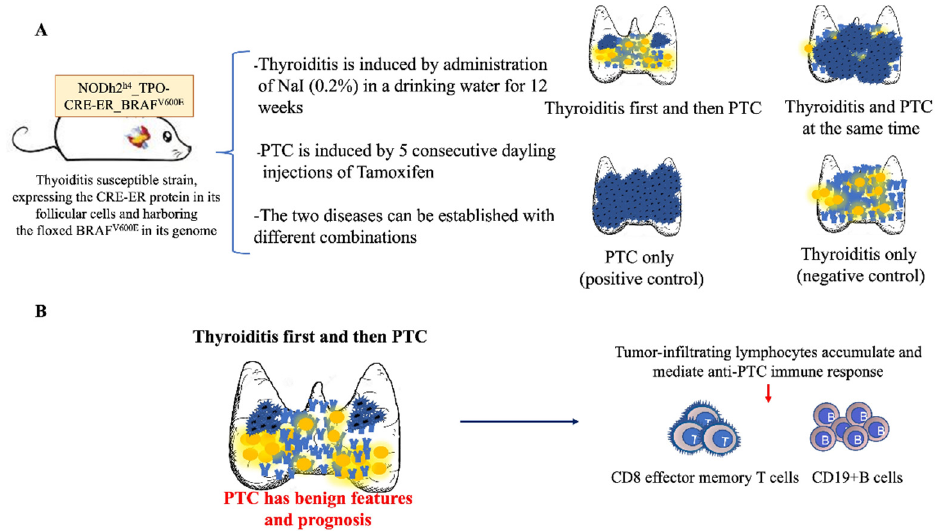
Figure 2. Mechanism underlying the beneficial role of pre-existing thyroiditis on PTC growth and pro- gression in a double transgenic mouse model NOD.H2 h4 _TPO-CRE-ER_BRAF v600E . ( A ) autoimmune thyroiditis and PTC induction. Autoimmune thyroiditis was induced by administration of sodium iodide (NaI) in the drinking water for 12 consecutive weeks. PTC is induced by five consecutive daily injections of Tamoxifen (100 mg/Kg i.p.). The two diseases can then be established with various combinations: Thyroiditis first and then PTC; Thyroiditis and PTC induced at the same time; PTC only (positive control); Thyroiditis only (negative control). ( B ) Pre-existing iodine-induced